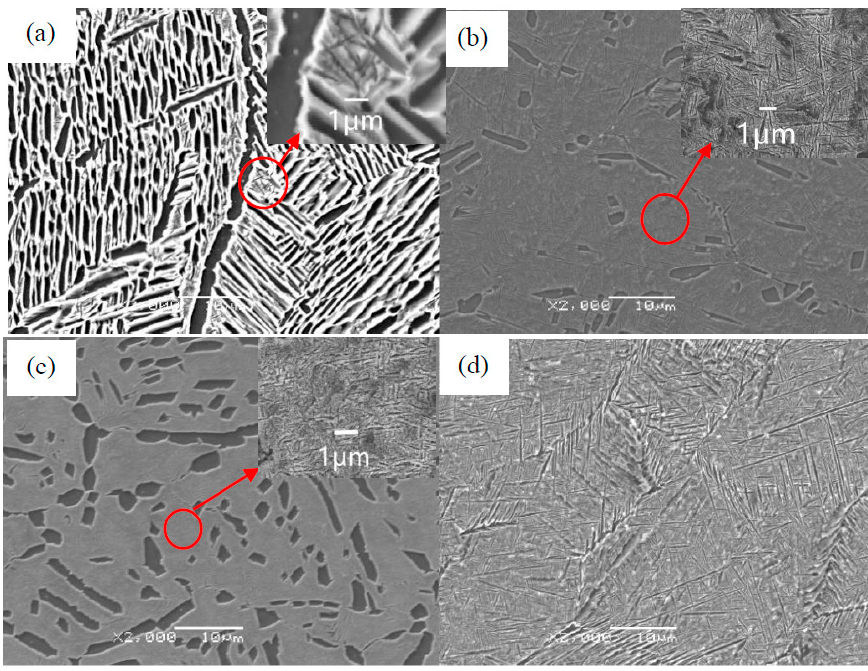
Figure 5. Microstructures of Ti600/Ti-22Al-25Nb welded joints after deformation at: ( a ) 950 °C; ( b ) 975 °C; ( c ) 990 °C; ( d ) 1010 °C.